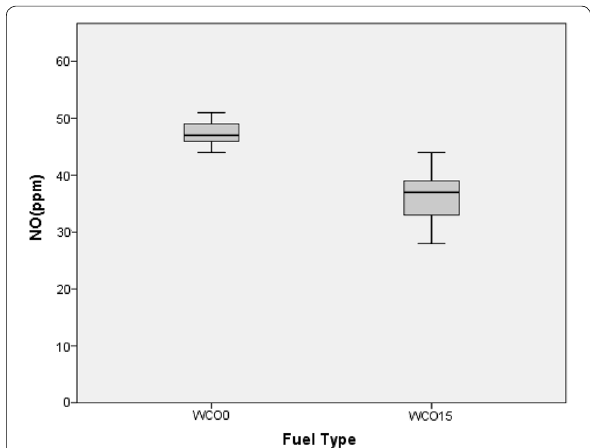
Fig. 7 Box plot diagrams of driving and exhaust characteristics [NO x emission (Unit: ppm)]